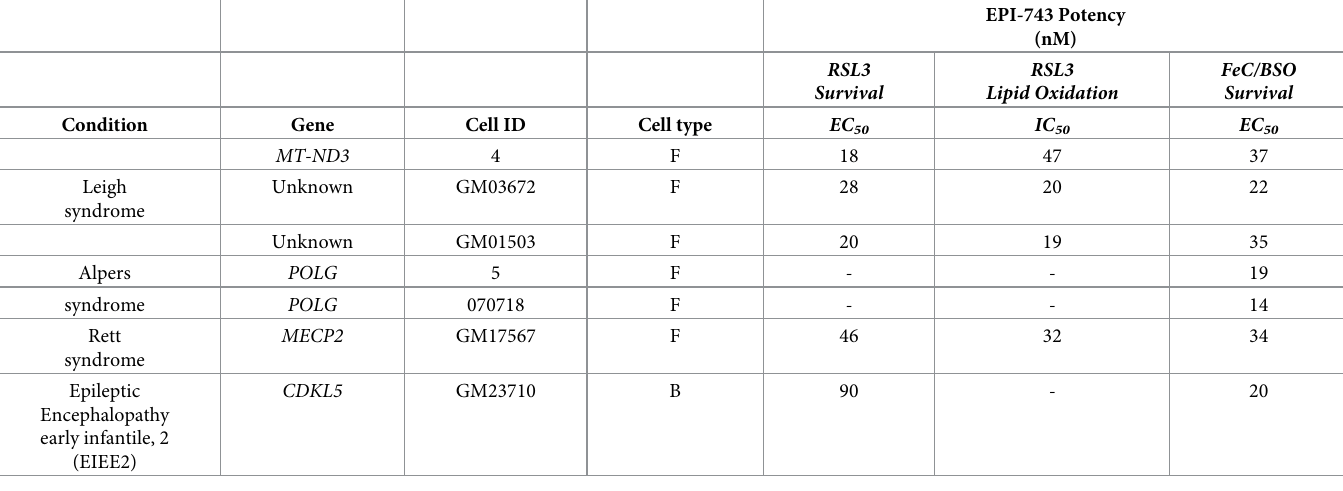
Table 3. Summary of EPI-743 ferroptosis rescue of cells derived from pediatric seizure disorder